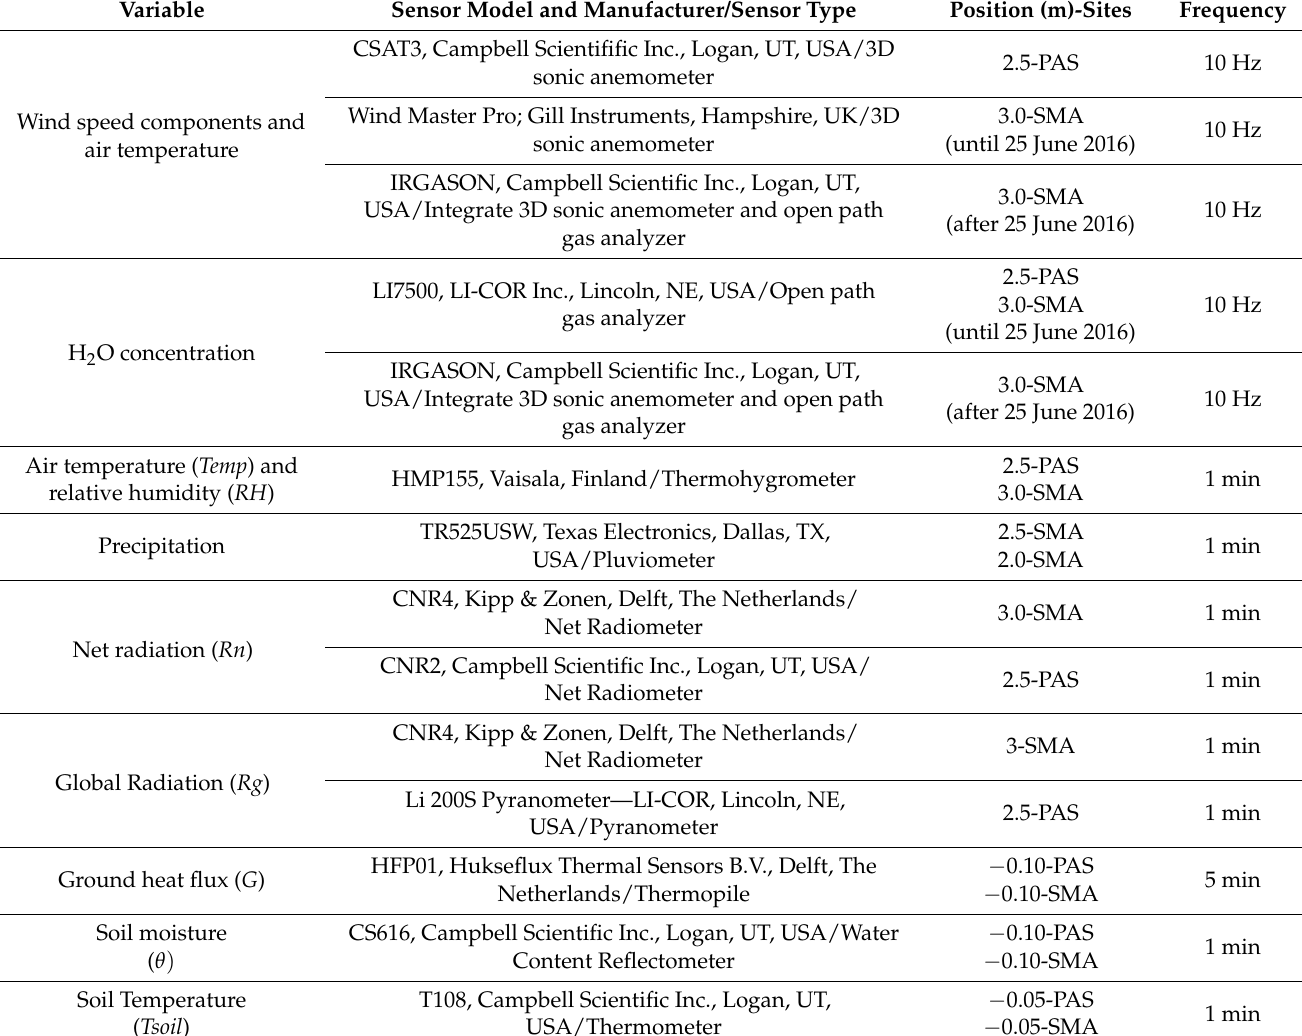
Table 1. Sensors installed at the flux towers used in this